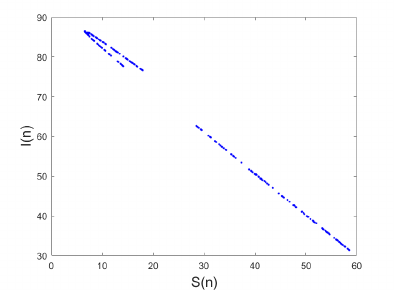
Figure 3. Phase portrait of the fractional SIR epidemic model in (11) with γ = 1 for N = 100, β = 0.8, σ = 0.1, p = 0.0005, and initial conditions ( S ( 0 ) , I ( 0 )) = ( 70,30 )